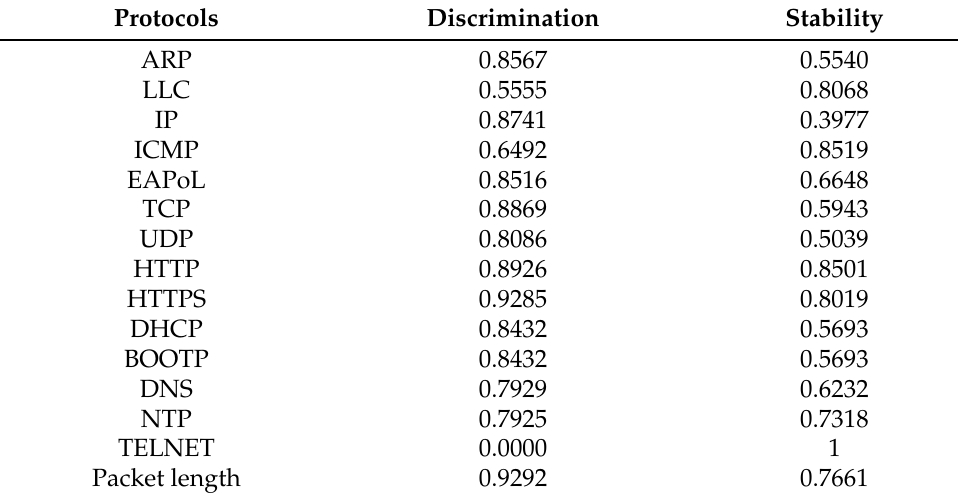
Table 4. Discrimination and stability of different